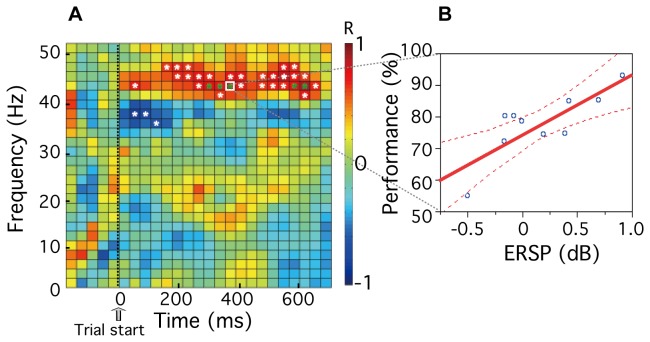
Relationship between event-related spectral perturbation (ERSP) and task performance within rCMA.
A, Correlation between ERSP values and task performance. White asterisks indicate time/frequency points where p < 0.05, mean r = 0.71. Multiple comparisons were corrected for the entire time period with a frequency of 43Hz, and results are indicated as green asterisks (p < 0.05, FDR corrected; df = 9, mean r = 0.79). B, Example of correlation between ERSP and task performance for the time/frequency point indicated by a white box in Panel A (t=355 msec, f=43.0 Hz). The solid red line shows linear regression fits to the data, and the broken lines show the 95% confidence interval.